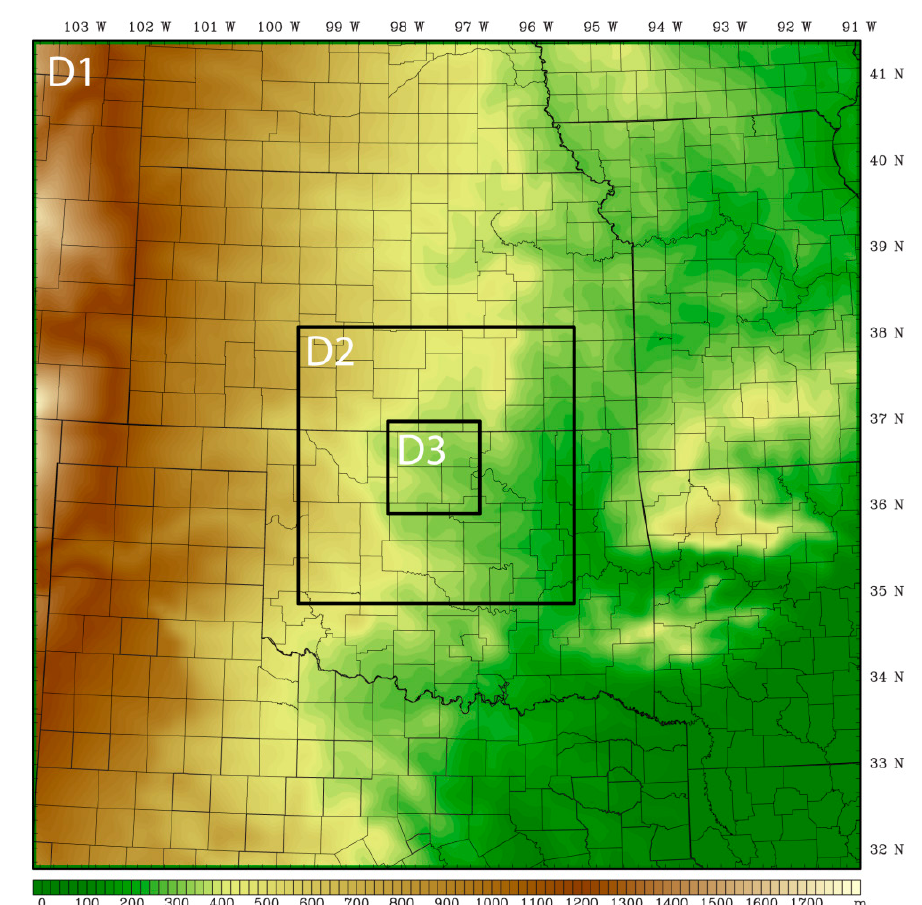
Figure 3. Elevation map showing the WRF model double nested domains used in this study. The inner domain, D3, is centered on the SGP ARM Central Facility in northern Oklahoma, USA. The horizontal grid resolution of domain 1 (labeled D1), domain 2 (D2), and domain 3 (D3) is 9, 3, and 1 km,